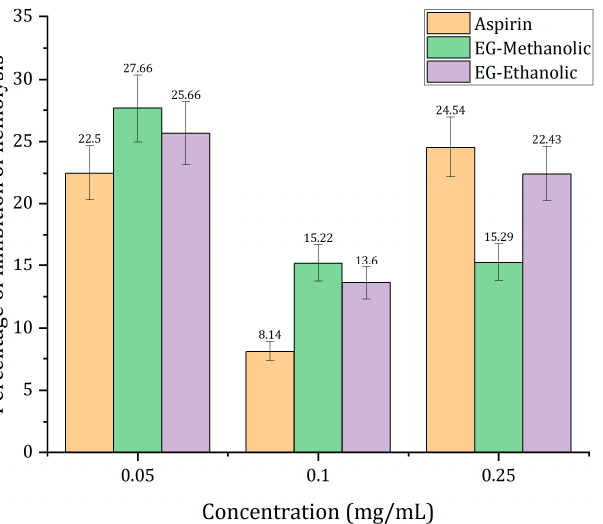
Figure 7. Anti-hemolytic activity of the plant extract comparing its effectiveness with the commer- cial